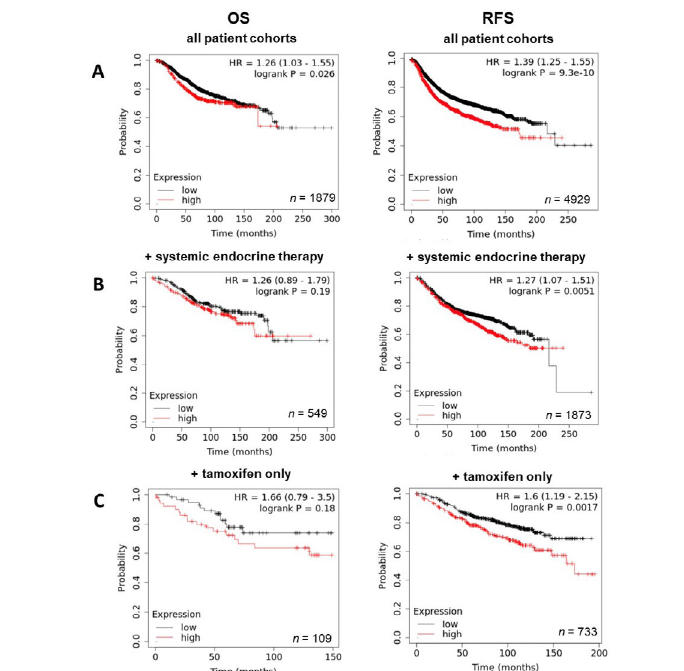
Figure 4. Kaplan-Meier plots describing ZIP7 mRNA expression relationship with OS and RFS, in breast cancer patients. All plots were generated using KMPlot [20] with expression cohorts defined by “auto-selected” cut-offs. Probe sets were optimized via “JetSet” function. Patient cohorts were progressively focused from unrestricted analysis (A), initially into those receiving systemic endocrine therapy (B), before isolating those specifically treated with tamoxifen (C). Hazard ratios (HRs) and significance values ( P ) are indicated on graphs, with the number of patients included in each analysis ( n )